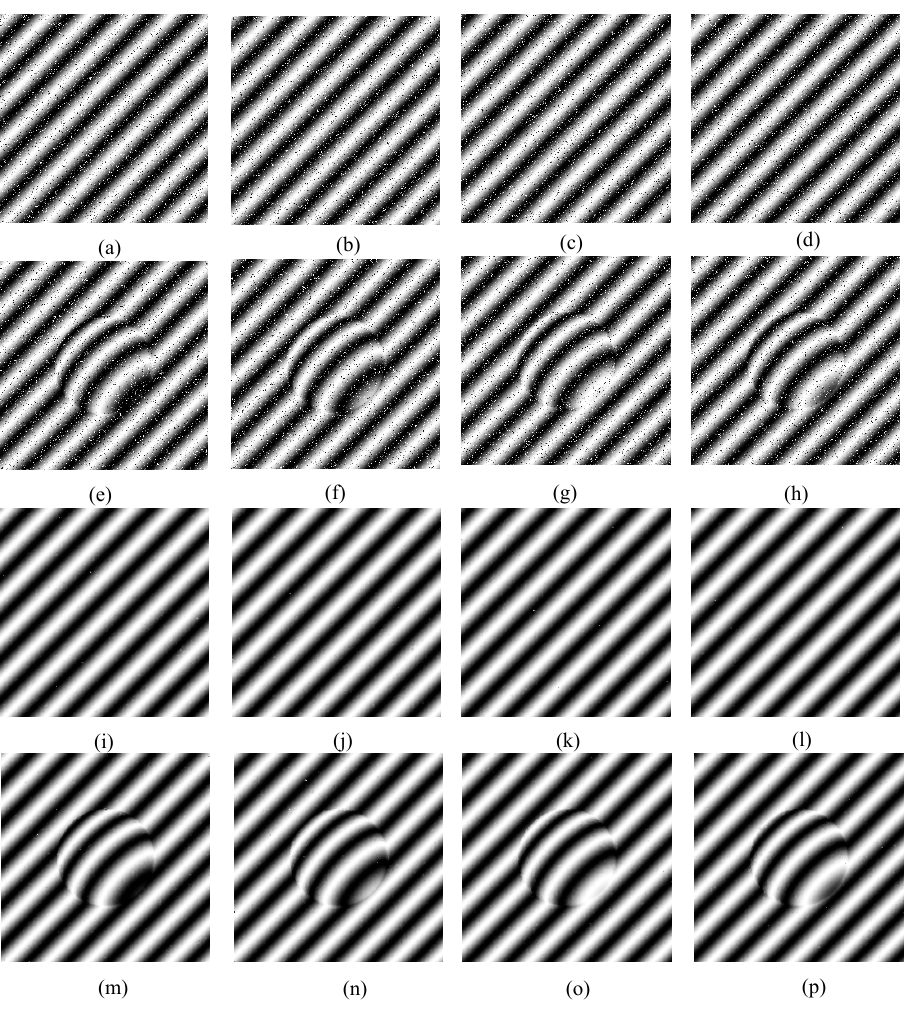
Figure 13. ( a – h ) The eight ciphertext images after adding salt and pepper noise with 0.1 density.